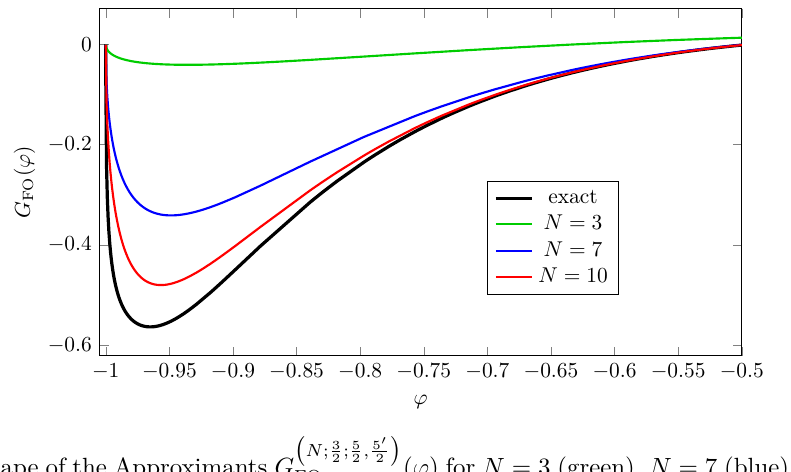
( x ) function in eq. (5.7) in the interval 0 ≤ x 0 FO